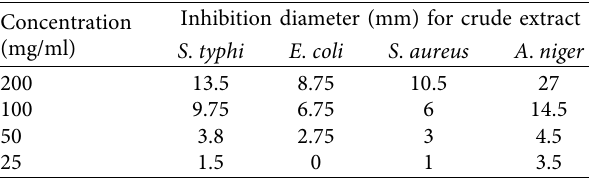
Table 1: Inhibition diameter (ID) of microorganisms at different concentrations.